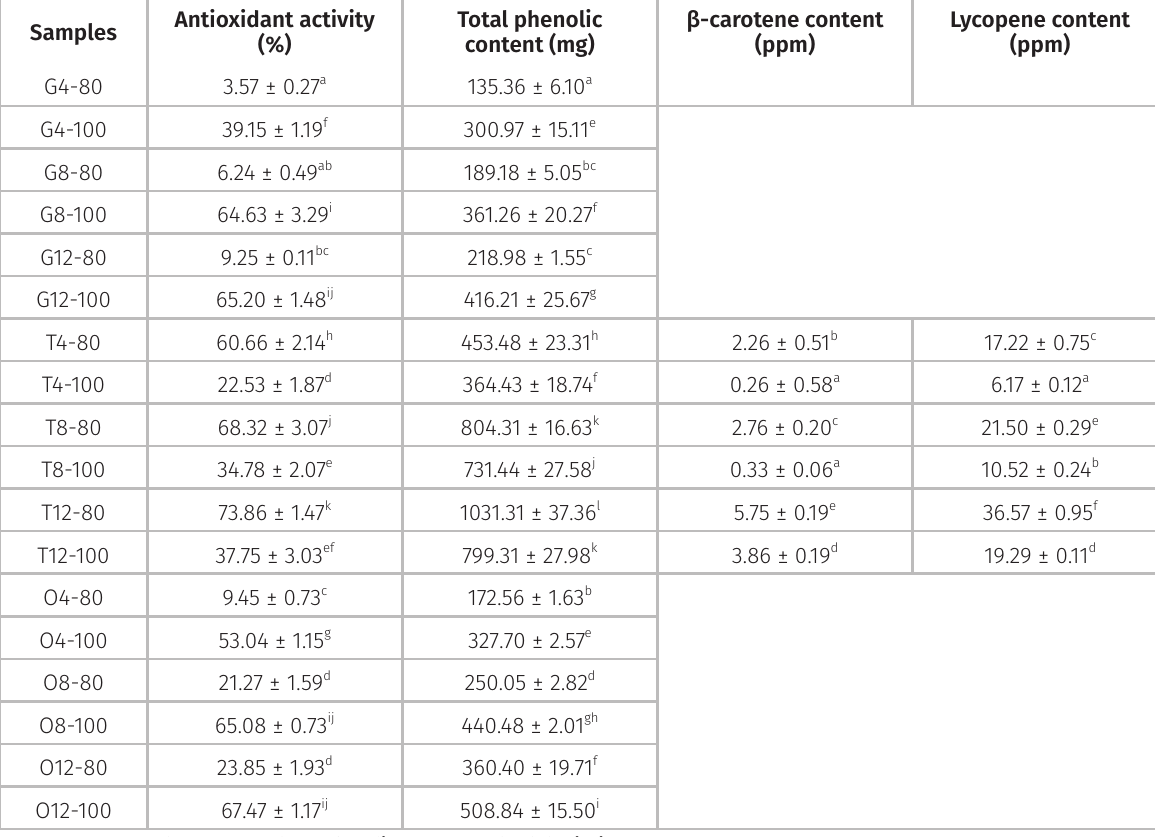
Table IV. Antioxidant activity and total phenolic content of all noodles fortified with vegetable powder and β-carotene and lycopene contents of the noodles fortified with tomato